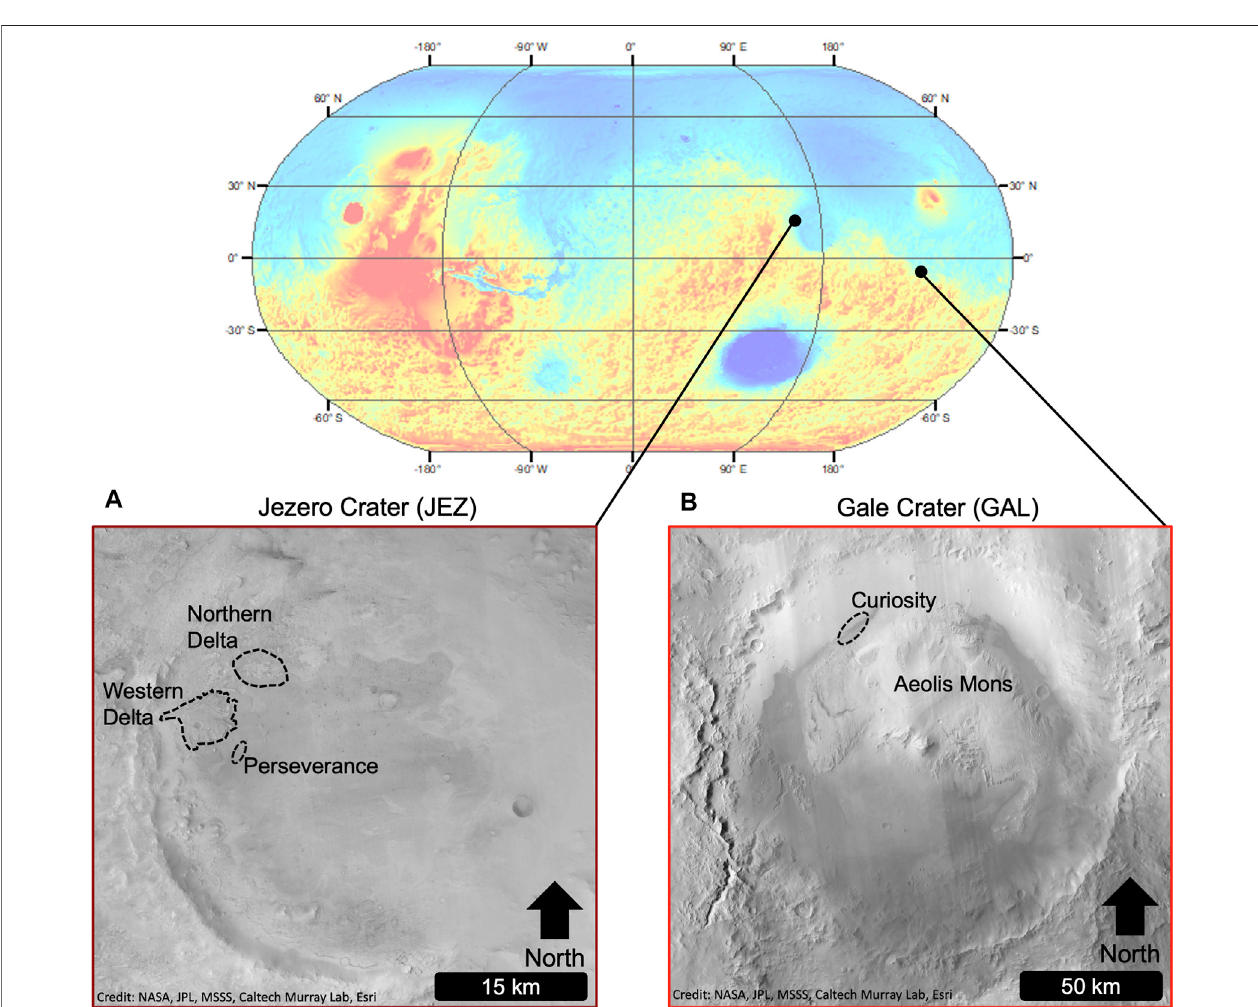
FIGURE 2 | Global context for Jezero and Gale craters on Mars. The Perseverance and Curiosity rovers are exploring these areas, which are probable targets for future life detection missions. (A) Jezero crater is characterized by deltaic deposits on the western and northern edges of the crater. The Perseverance rover ’ s approximate area of operation (as of December 2021) is shown. (B) Gale crater contains the prominent Mt. Sharp (Aeolis Mons) deposit. The Curiosity rover ’ s approximate area of operation (as of December 2021) is shown north of Aeolis Mons.